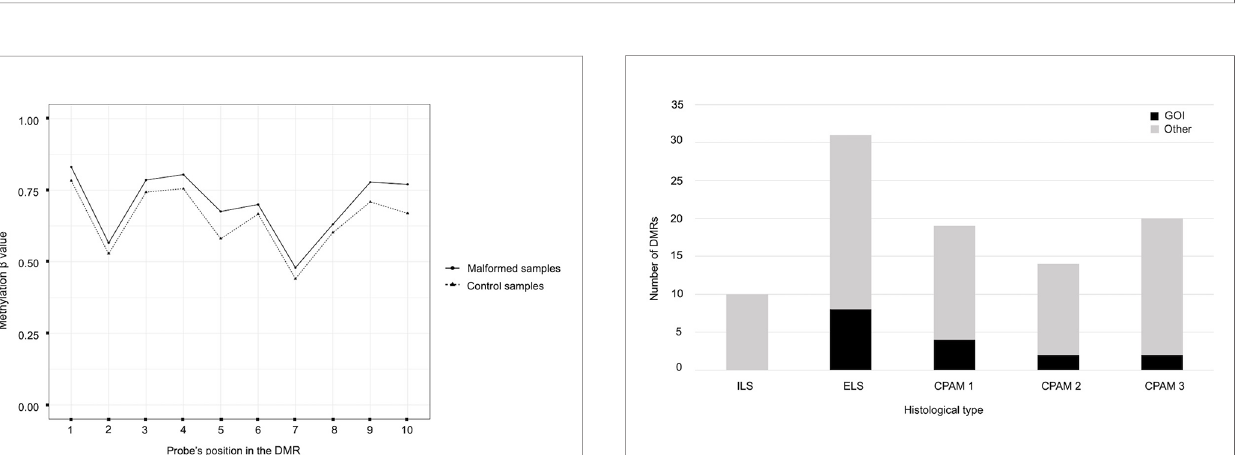
FIGURE 3 | Number of signi fi cant DMRs (adjusted p-value < 0,05), close to GOI (black) and to different genes (gray), identi fi ed when the cases of same histology were compared